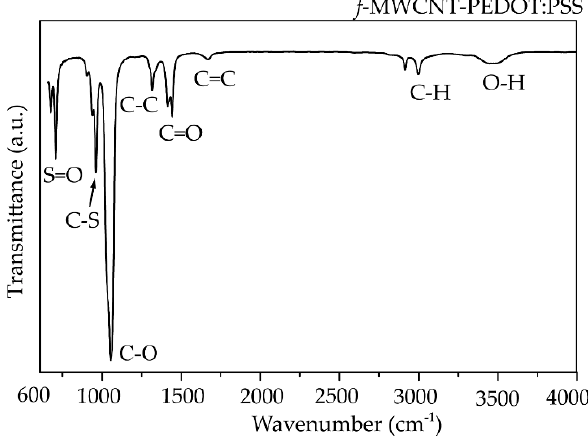
Figure 6. FTIR spectrum of f -MWCNT-PEDOT:PSS.